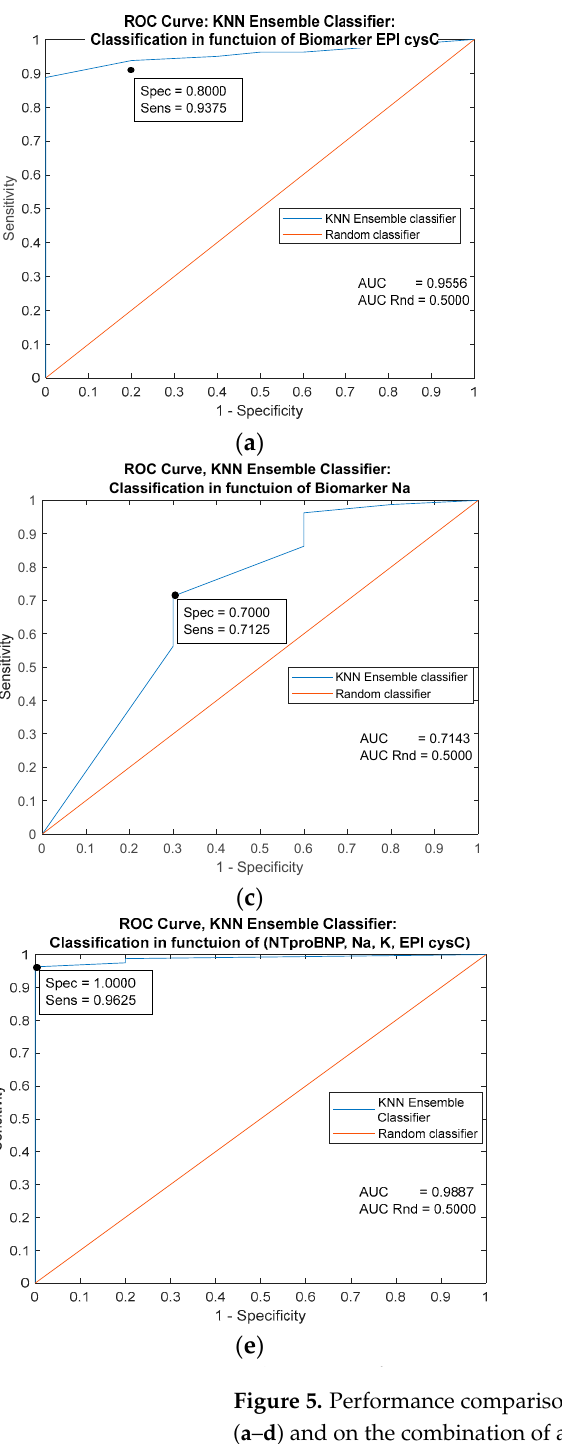
ROC Curve, KNN Ensemble Classifier: Classification in functuion of Biomarker Na